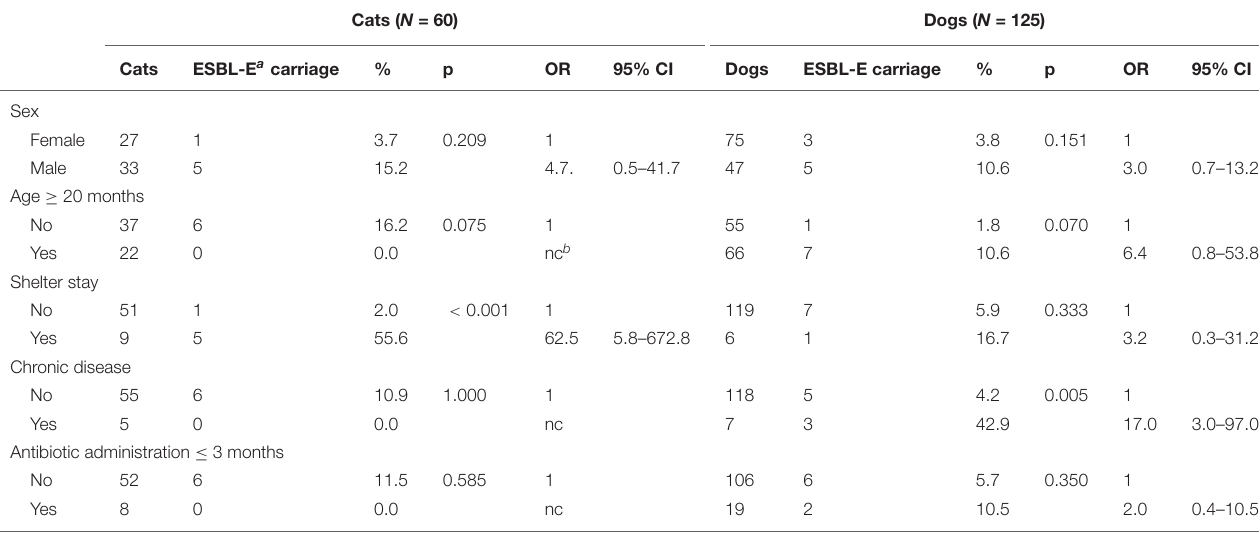
TABLE 1 | Risk factors for extended-spectrum beta-lactamase producing- Enterobacteriaceae rectal carriage in cats ( N = 60) and dogs ( N = 125) from Guadeloupe (French West